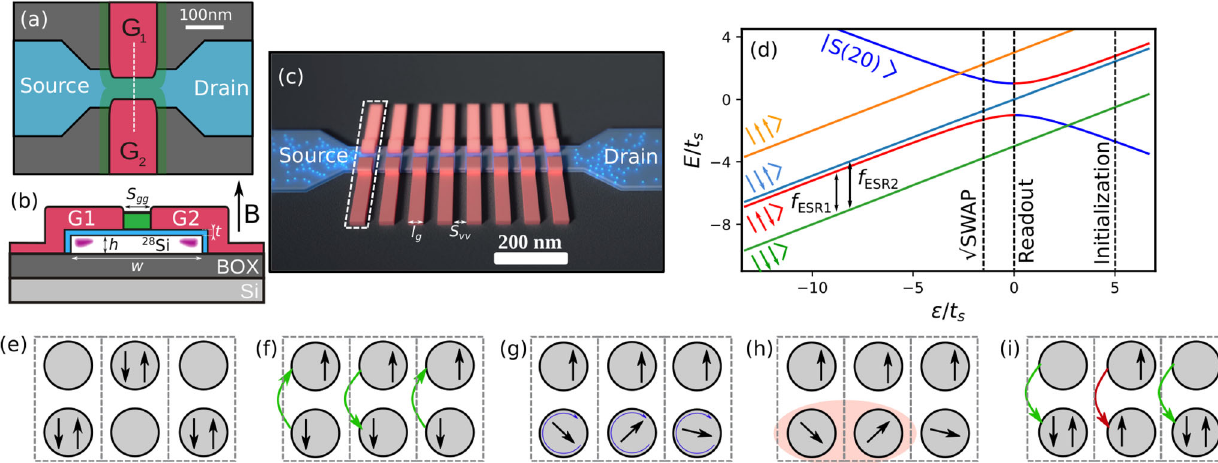
Fig. 2 Split gate submodules. a Top view of a single split-gate nanowire transistor, with highly-doped source and drain ohmic contacts in blue, metallic split gates (G1 and G2) in orange, Si 3 N 4 spacer in green and buried oxide in black. b Schematic cross section of the split-gate transistor along the dashed line in a . The gates and silicon nanowire are isolated by the gate oxide of thickness t . The metal gate stack TiN(5 nm)/Polycrystalline silicon (50 nm) is represented in pink. S gg indicates the edge-to-edge separation of the split gates. The silicon nanowire height and width are h and w , respectively. The purple regions represent schematically the QD wavefunctions. BOX stands for buried oxide. The vertical black arrow represents the direction of the external magnetic fi eld. c An 8 split-gate 1d submodule. Dashed lines highlight a one- qubit split gate subset. S vv indicates the edge-to-edge separation between splits and l g the gate length. d Energy spectrum versus energy detuning of the two-spin system in a tunnel-coupled DQD. Both energy and detuning are normalized by the "#j i (cid:3) S ð 20 Þj i tunnel coupling, t s . The diagram is simulated using a 5% g-factor difference and an average Zeeman energy of three times t s . e – i Schematic of operating 3 qubits in a 2 × 3 QD array formed by 3 split gates as indicated by dashed lines. Initialization e , f , one-qubit gates g , two-qubit exchange interaction h , and readout via Pauli spin blockade i